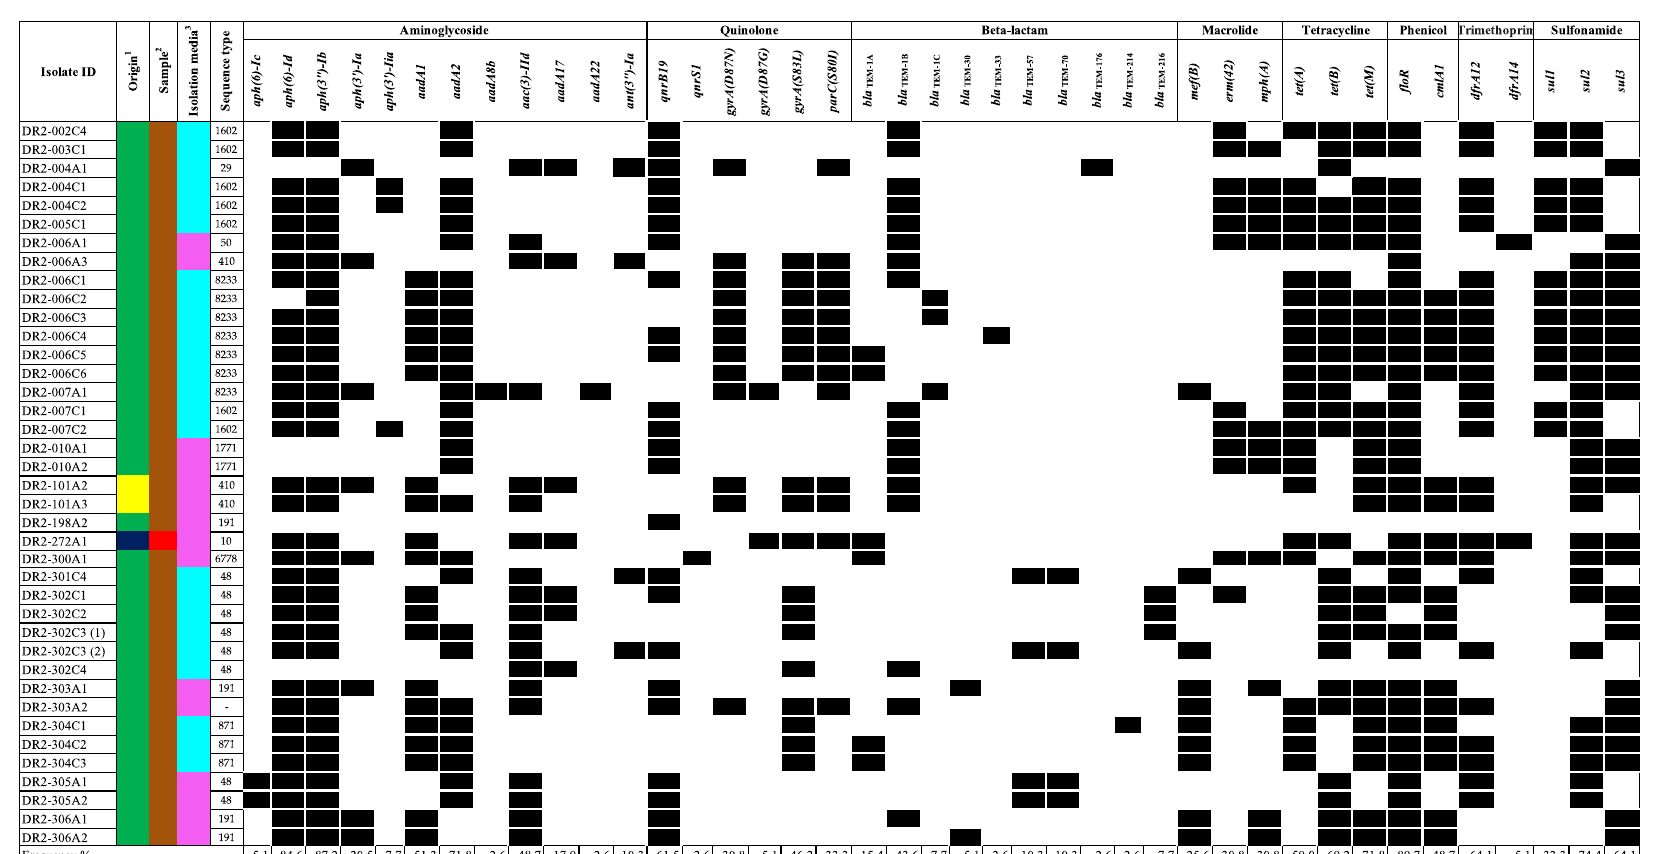
Figure 2. Distribution of AMR determinants on mcr -positive isolates for aminoglycosides, quinolones, beta-lactams, macrolides, tetracyclines, phenicol, trimethoprim, and sulfonamides. Black cells and white cells indicate the presence and absence of genes in the bacterial genome, respectively. For origin 1 , the colors navy blue, yellow, and green, represent beef cattle, chicken, and swine, respectively. For sample 2 , the colors brown and red represent feces and meat, respectively. For isolation media 3 , the colors pink and light blue represent VRBG0 and XLT4/BGS, respectively.